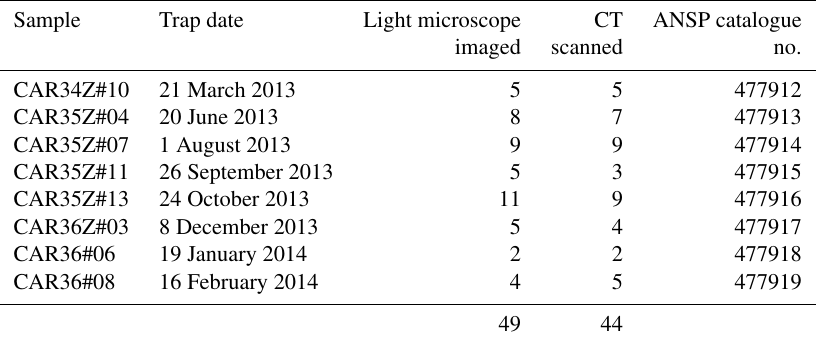
Table 1. Number of specimens imaged and CT scanned from each sediment trap cup, with corresponding Academy of Natural Sciences of Drexel University (ANSP) lot catalogue numbers.